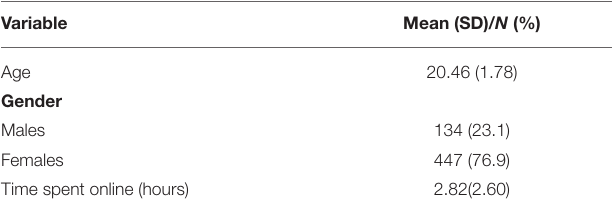
TABLE 1 | Descriptive statistics of demographic variables.